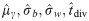
True vs. estimated values of the four model parameters.The true values (x-axes) of the four parameters (μγ, σb, σw, tdiv) and their corresponding model estimates (y-axes) (μ^γ,σ^b,σ^w,t^div) for the two simulated data sets. Straight lines represent y = x.